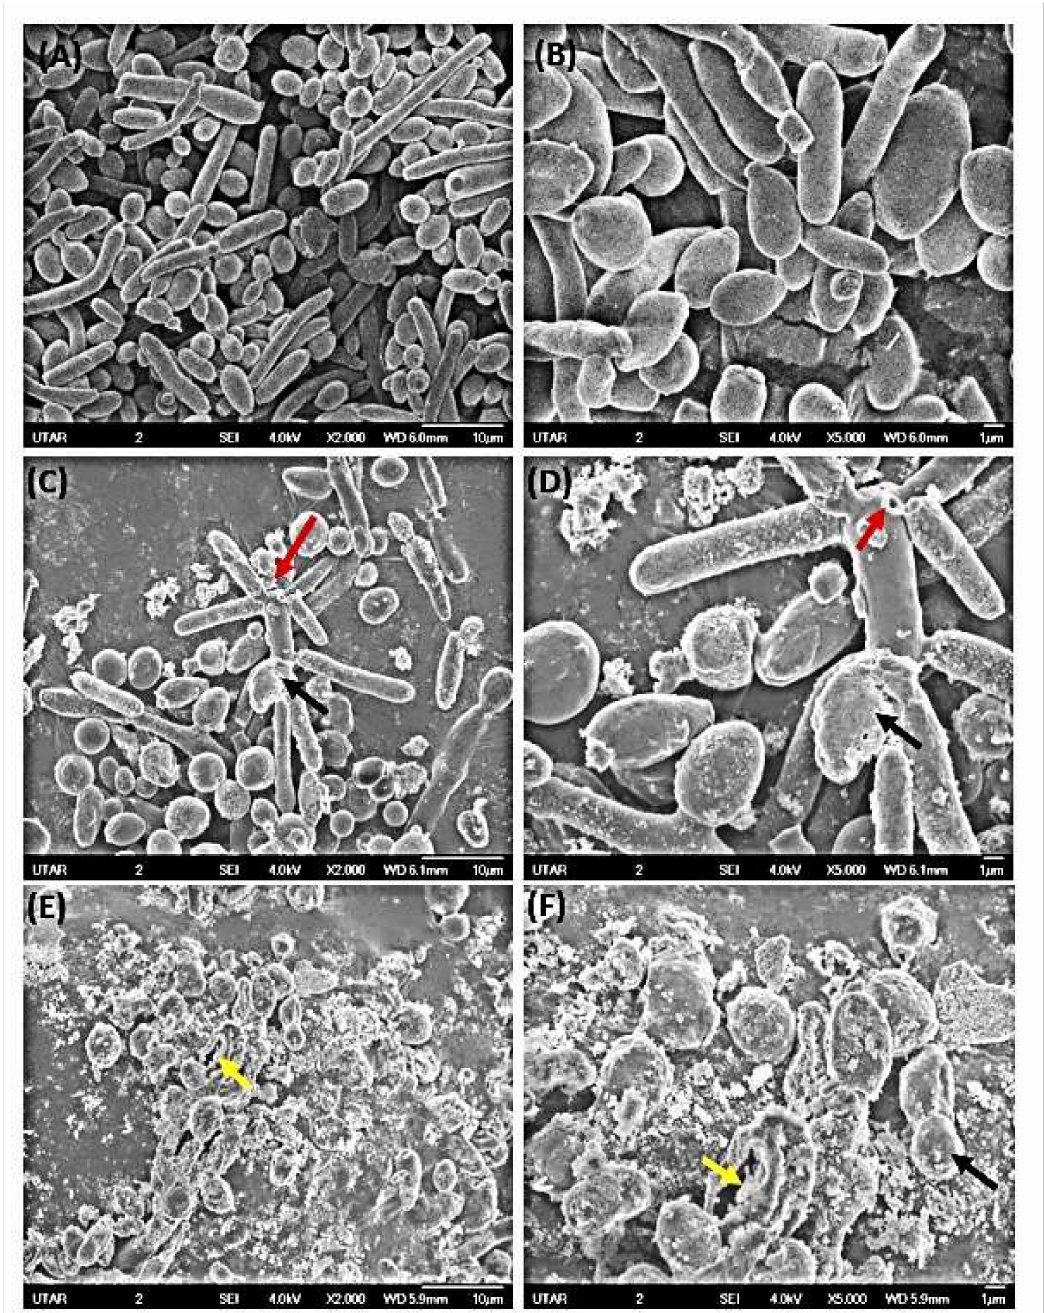
Figure 8. SEM images of C. albicans without ZnO NPs treatment (negative control) ( A , B ); treatment with 80 µ g/mL of ZnO NPs showed breakage of hyphae (red arrow) and pitting of yeast surface (black arrow) ( C , D ); treatment with 160 µ g/mL of ZnO NPs showed invagination of yeast cell surface (blue arrow) and rupture of the cell membrane (yellow arrow) ( E , F ) after 24 h